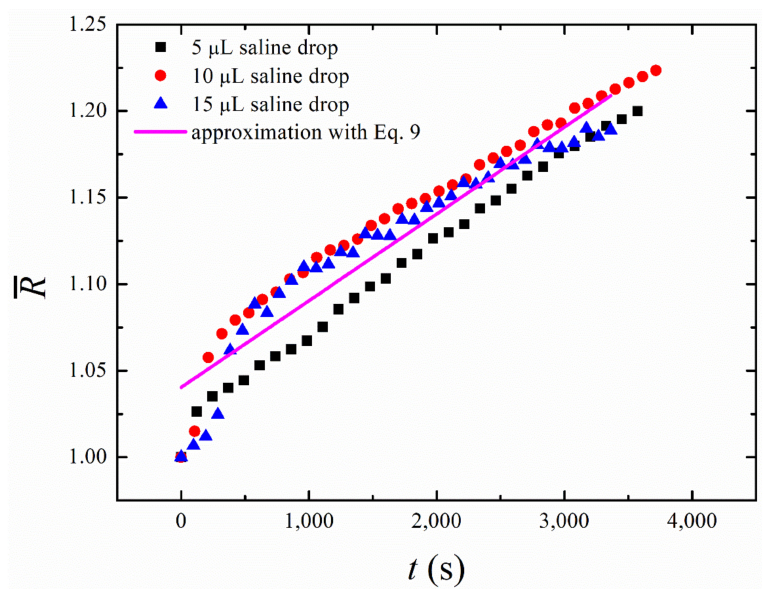
Figure 7. Experimental curves describing the osmotic evolution of a droplet of different initial volumes V 0 during the “short-time” growth are presented (black squares— V 0 = 5 µ L, red circles— V 0 = 10 µ L; blue triangles— V 0 = 15 µ L); the solid line demonstrates the best linear fitting of the experimental data for V 0 = 15 µ L. The osmotic growth is satisfactorily approximated by the universal linear time dependence, reproduced by the solid line, whose slope is independent of the initial volume of a